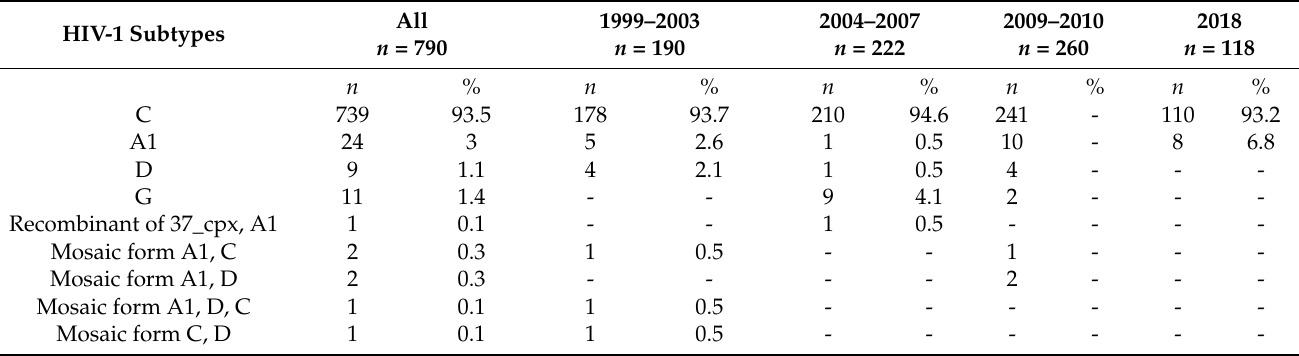
Table 1. Overall time trends for the subtype distribution between 1999 and